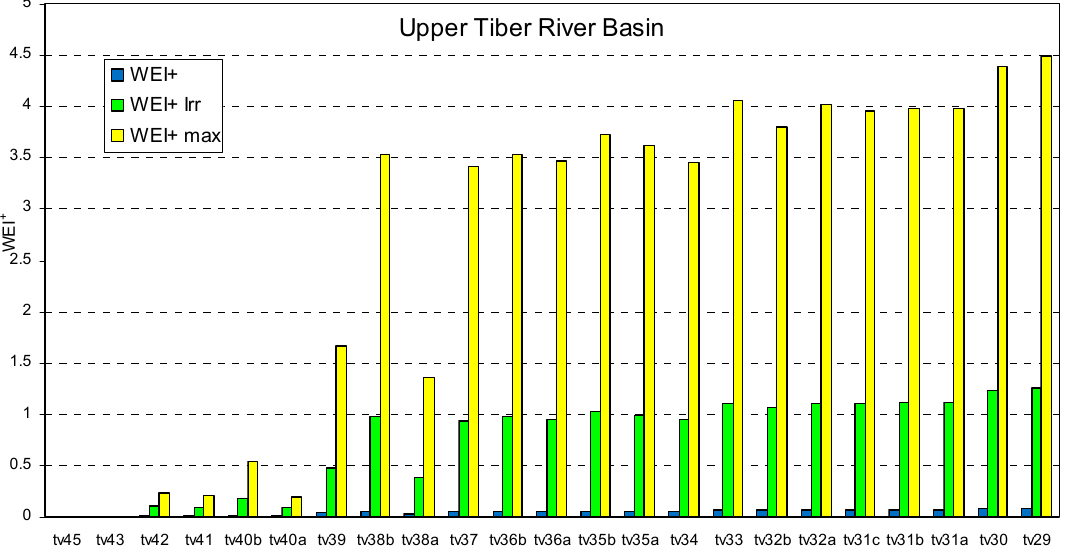
Figure 8. WEI + in the Upper Tiber River sub-basins.